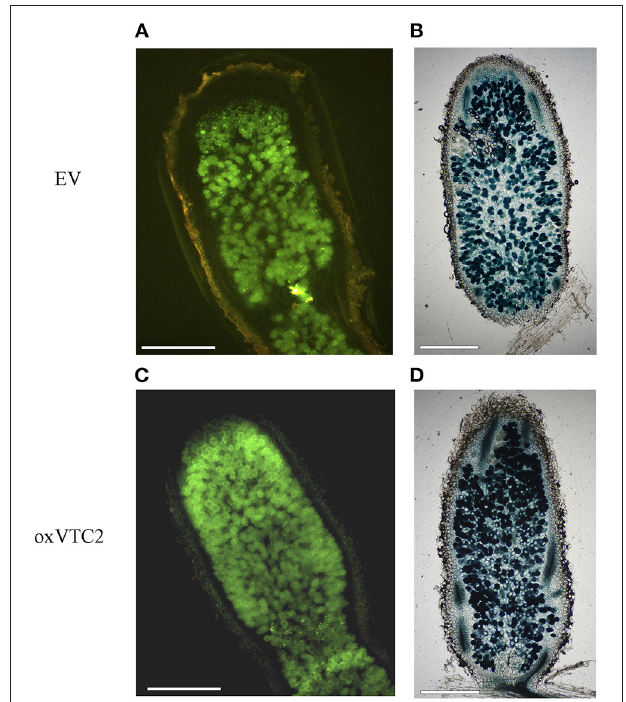
FIGURE 2 | Representative images of M. truncatula root nodule sections of the EV (A,B) and oxVTC2 lines (C,D) upon inoculation with E. meliloti bacteria constitutively expressing GFP (A,C) or LacZ (B,D) . Six weeks after inoculation nodules were collected, sectioned (and stained in the case of LacZ), and visualized using a fluorescent or light microscopy. Selected images are representative images corresponding to observations carried out in two independent experiments. Scale bars represent 500 µ